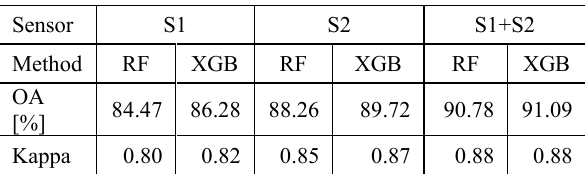
Table 6. OA and Kappa values of RF and XGB, as applied to the multitemporal S1 and S2 imagery.